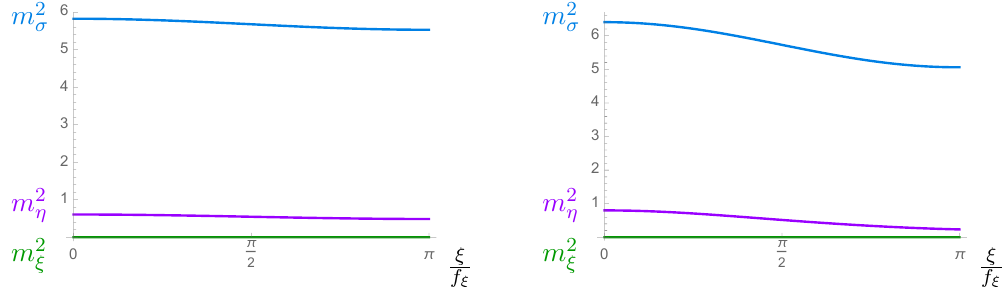
Figure 9 . Mass-hierarchy between the in(cid:13)adrons ( (cid:27); (cid:17) ) and in(cid:13)aton (cid:24) (measured in units 10 32 GeV 2 ) as a function of the in(cid:13)aton vev for the parameter choice (cid:22) = 10 (cid:21) = (cid:20) = 10 M = 10 16 GeV (left) and (cid:22) = 10 (cid:21) = (cid:20) = 2 M = 10 16 GeV